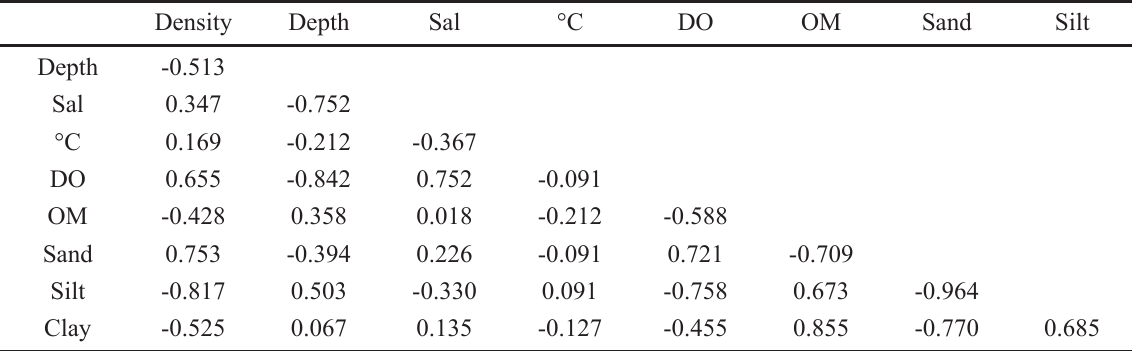
Table 7. Spearman’s correlation coefficient between density of Typhlamphiascus medici sp. nov. and environmental variables. Sal = salinity; °C = temperature; DO = dissolved oxygen; OM = organic matter